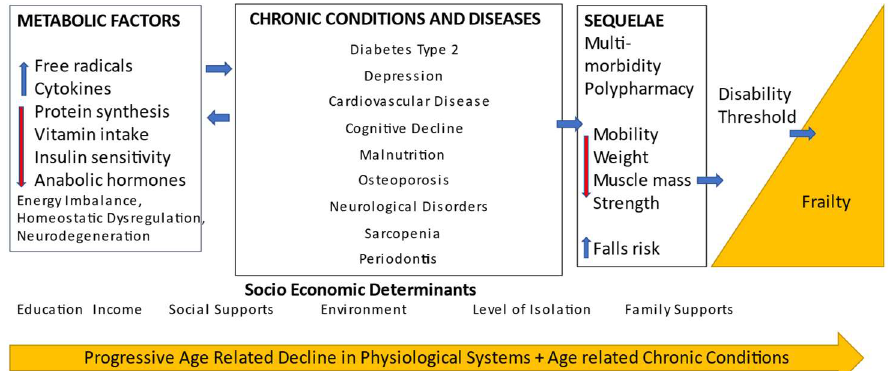
Figure 1. Factors contributing to the incidence of frailty [Adapted with permission from Ref. [39].